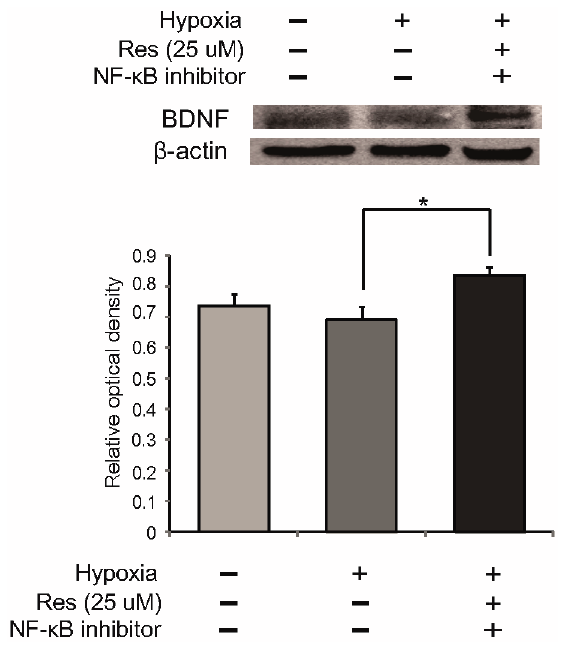
Figure 6. The measurement of BDNF expression in resveratrol pre-treated microglia with NF- κ B inhibitor. To confirm the relationship between BDNF expression and NF- κ B activation in resveratrol pre-treatment, we examined the protein level of BDNF in BV2 microglia using western blot analysis after 100 nM NF- κ B inhibitor (Santa Cruz, CA, USA) pre-treatment at 3 h before hypoxia injury. After hypoxia injury, the protein level of BDNF was increased in the 25 μ M resveratrol with 100 nM NF- κ B inhibitor pre-treatment group. β -actin was used as an internal, loading control (mean ± S.E.M., n = 3). * p <